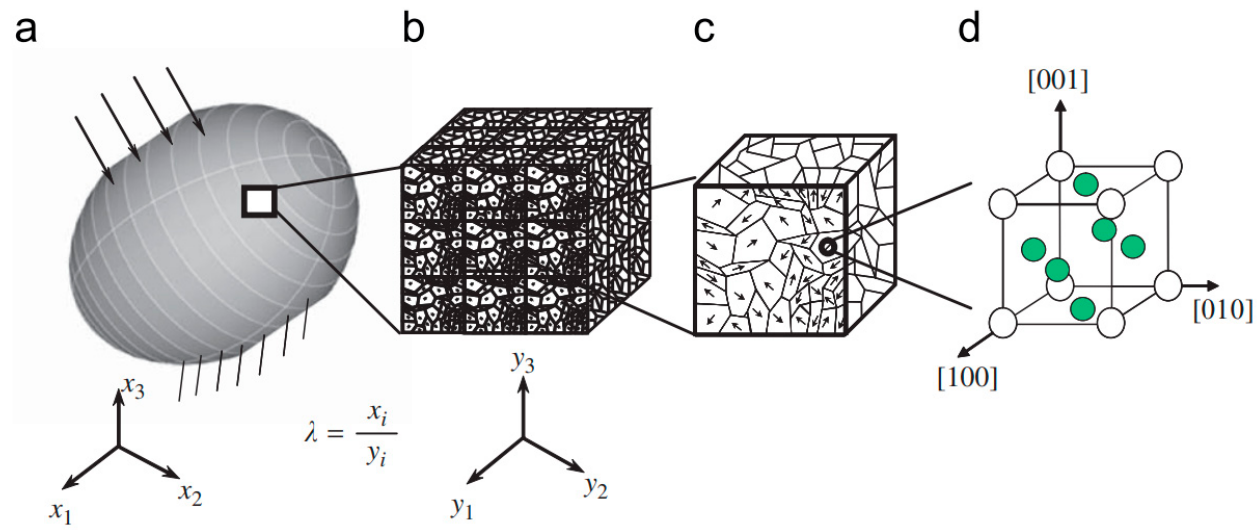
Figure 3. Double scale structures, coordinates, RVE, and FCC crystal lattice structure. ( a ) The macro-continuum; ( b ) The micro-polycrystal structure; ( c ) RVE; ( d ) Crystal lattice. (Reproduced from [28], with permission from Elsevier, 2009).